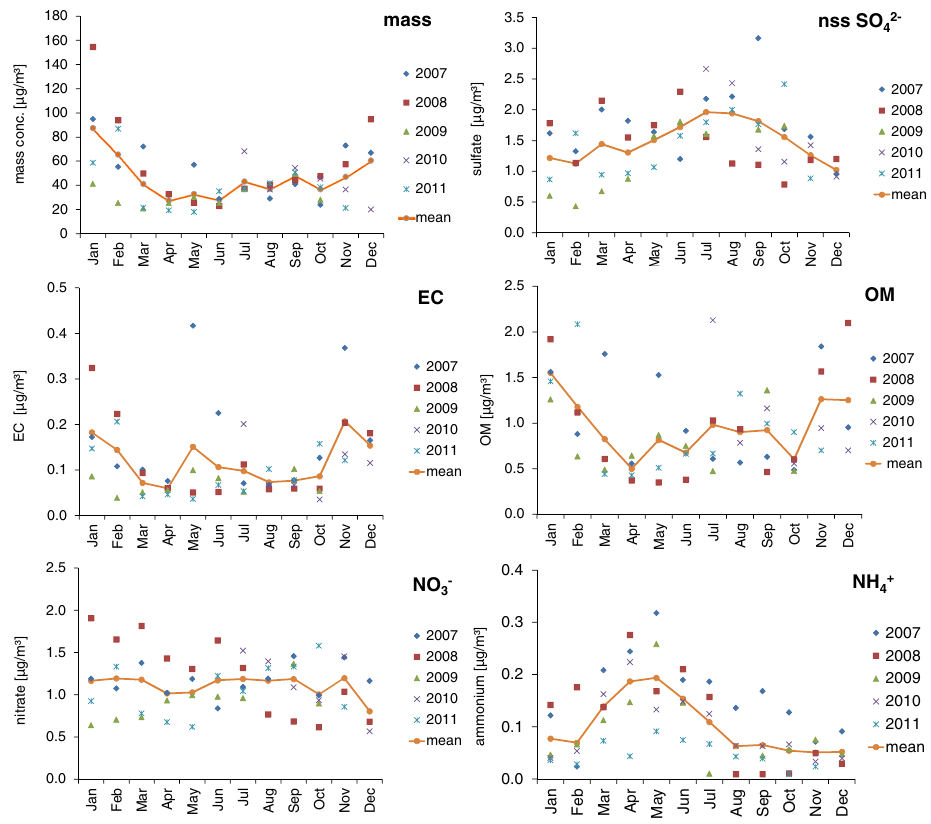
Figure 4. Annual variability and monthly mean of PM 10 mass concentration, non-sea-salt sulfate, elemental carbon (EC), organic matter (OM), nitrate and ammonium during the 5 years of measurements for samples collected on the tower. Table 3. Seasonality of PM 10 particle mass concentration collected with a DHA-80 HV filter sampler between January 2007 and November 2011 on top of the tower ∗